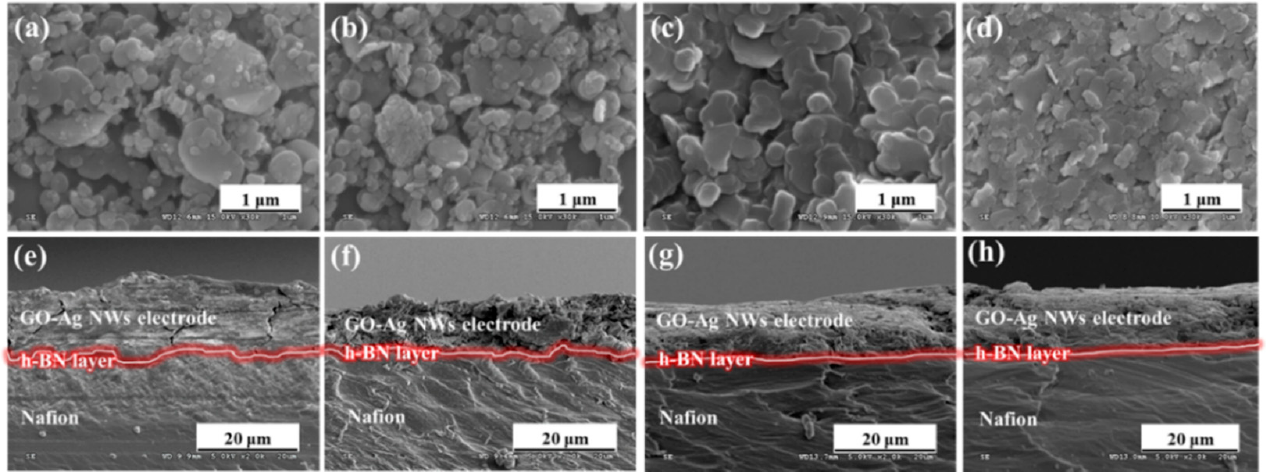
Figure 2. Top and cross-sectional scanning electron microscopy (SEM) images of IEAP actuators with h-BN insulating layers with different particle sizes: ( a , b ) 1 μ m, ( c , d ) 800 nm, ( e , f ) 300 nm, and ( g , h ) 170 nm.